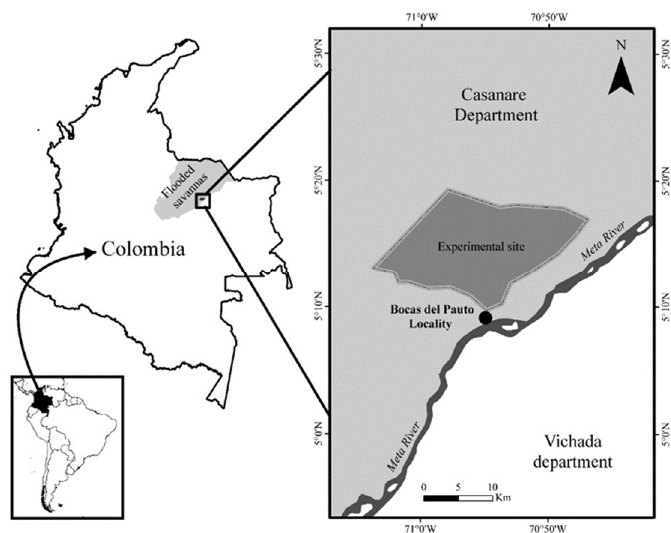
Figure 1. Location of the study site.